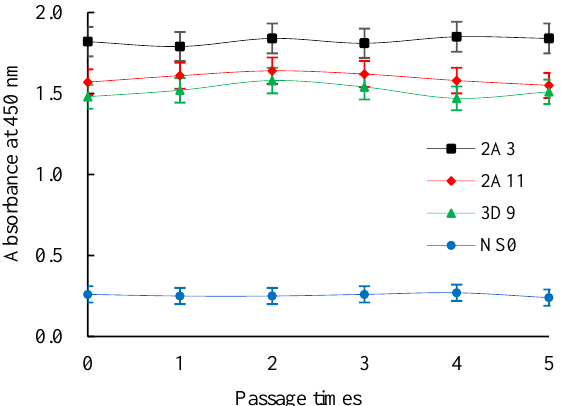
Figure 6. The Ka curves of Cr( Ш ) － EDTA mAbs. Ka: affinity constant. 2.7. IcELISA Optimization and Establishment of IcELISA Standard Curve 2.7.1. IcELISA Optimization The chessboard titration results indicated that the optimal concentration of the coat- ing antigen Cr( Ш ) － iEDTA － OVA was 2.0 µg/mL, mAb 2A3 was 0.6 µg/mL (1:20,000), and GaMIgG － HRP was 0.6 µg/mL (1:1000) (data not shown). Four combinations of mAb dilution buffer and standard preparation buffer were performed to investigate the effect of the assay buffer. As shown in Table 2, when Cr(III) － EDTA and 2B6 mAb were dis- solved in Hepes buffer solution (HBS), IC50 was slightly decreased and Amax/IC50 was slightly increased, indicating that the K + concentration had a certain effect on icELISA per- formance. Therefore, HBS was chosen as assay buffer. The effect of HBS buffer ionic strength on icELISA is shown in Figure 7. The results showed that with the continuous increase in ionic strength, the Amax/IC50 gradually decreased while the IC50 value grad- ually increased, i.e., the sensitivity of icELISA decreased. Therefore, the best minimum NaCl content in HBS buffer was 137 mM; hence, there was no need to increase the ionic strength. The effects of the pH values on the icELISA are shown in Figure 8. The pH values